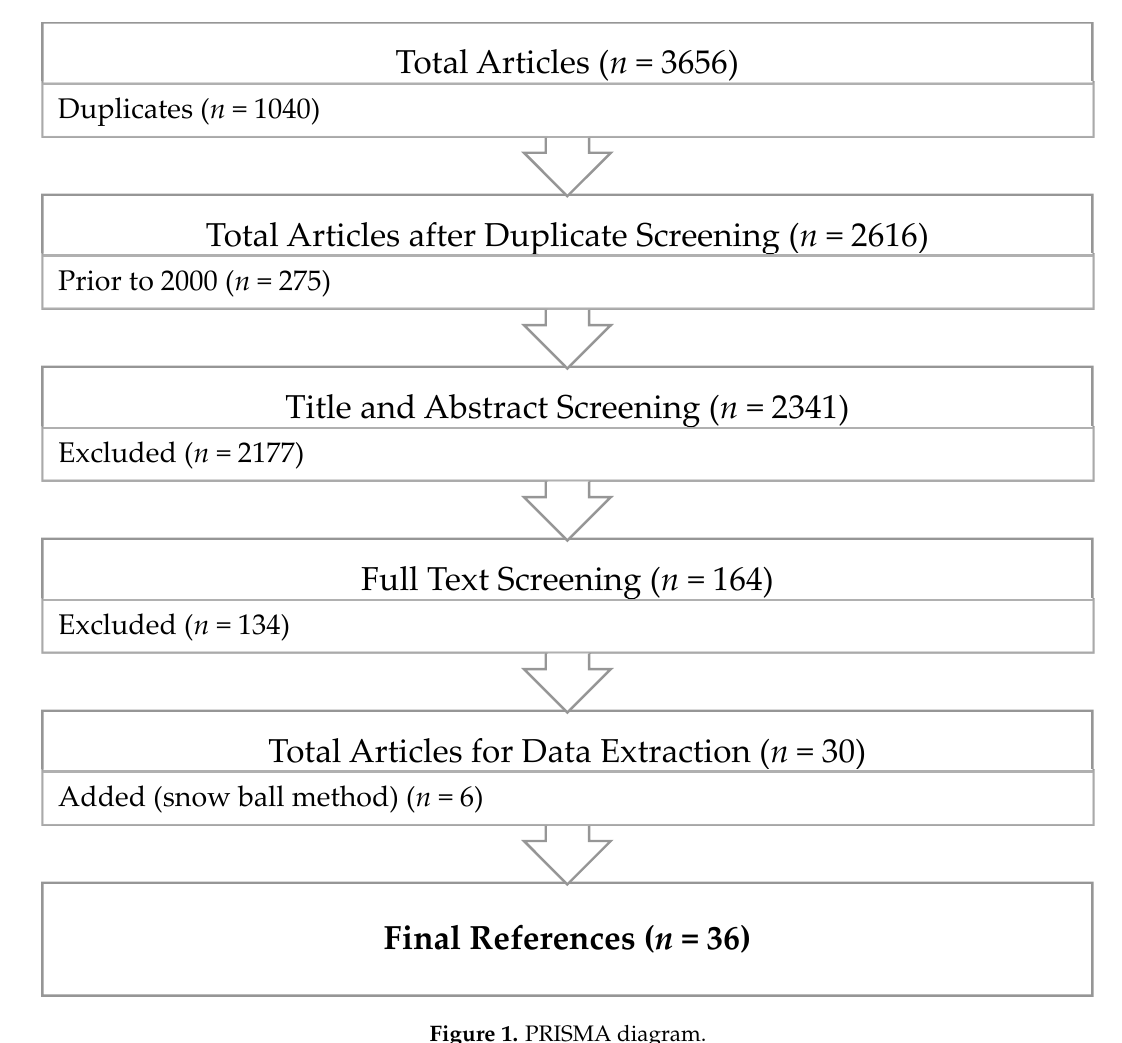
Figure 1. PRISMA diagram.